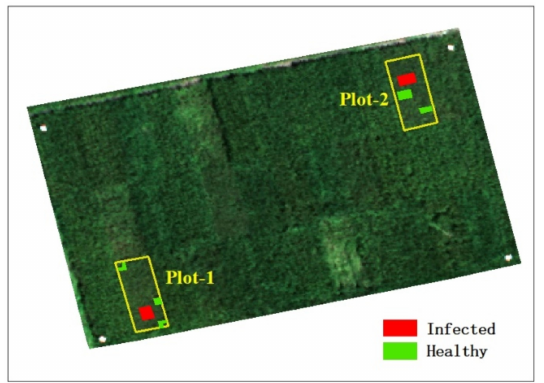
Figure 3. UAV image showing samples of healthy and infected